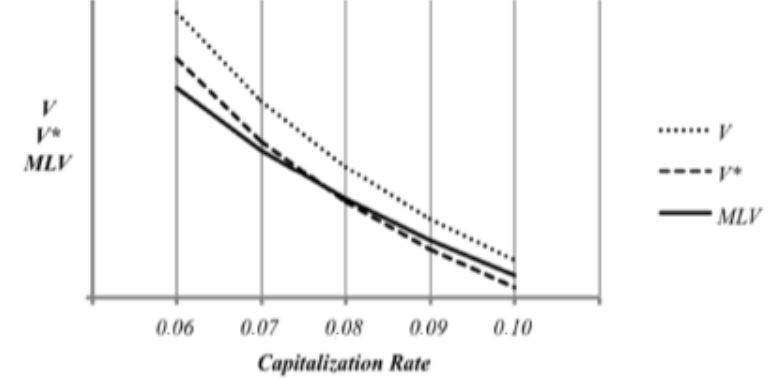
Figure 2. Relationship between V , V*, and MLV and the capitalization rate. The market value, the bottom value, and the MLV decrease with the capitalization rate and tend to converge at higher rates. The bottom value is greater than MLV until a